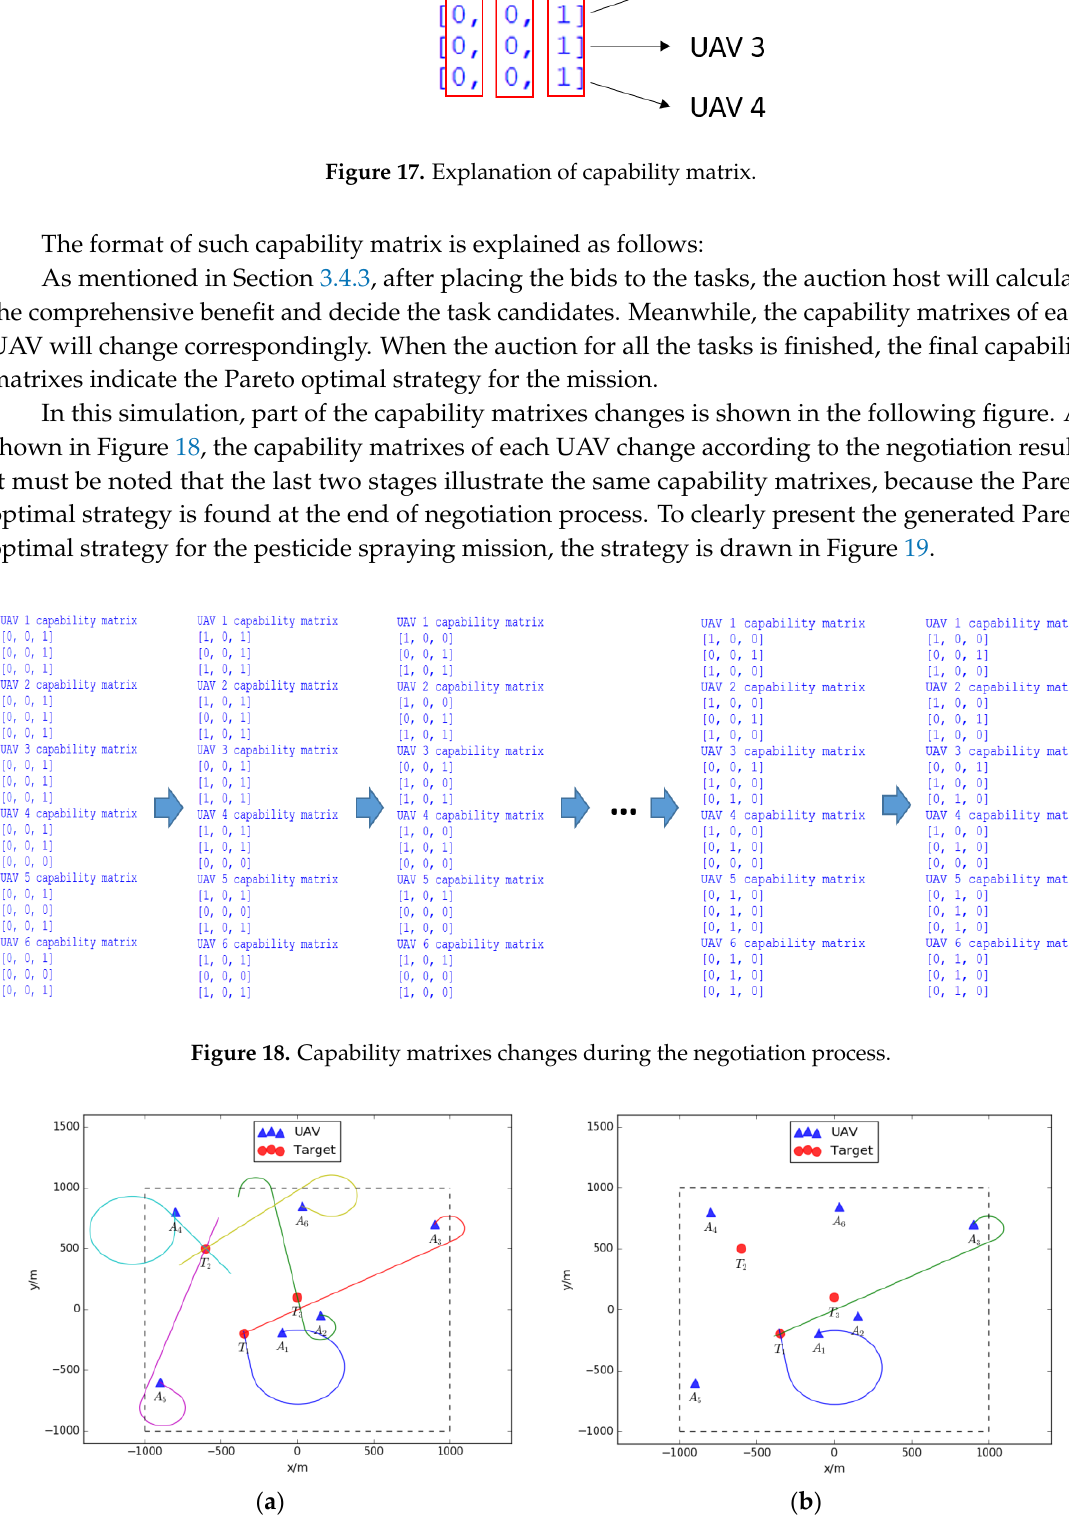
( d ) Figure 19. The simulation result: ( a ) overall view of the strategy; ( b ) the strategy for the first target; ( c ) the strategy for the second target; ( d ) the strategy for the third target. As shown in Figure 19a–d, the first target is assigned to the agent coalition with UAV 1 and 3, the second target is assigned to the agent coalition with UAV 4, 5 and 6, and the third target is assigned to UAV 2. According to Figure 19a, the six UAVs are forming improved federal architectures mentioned in Section 2.1. The construction of proposed improved federal architectures is shown in Figure 20. Figure 20. Agent formation in pesticide spraying mission.